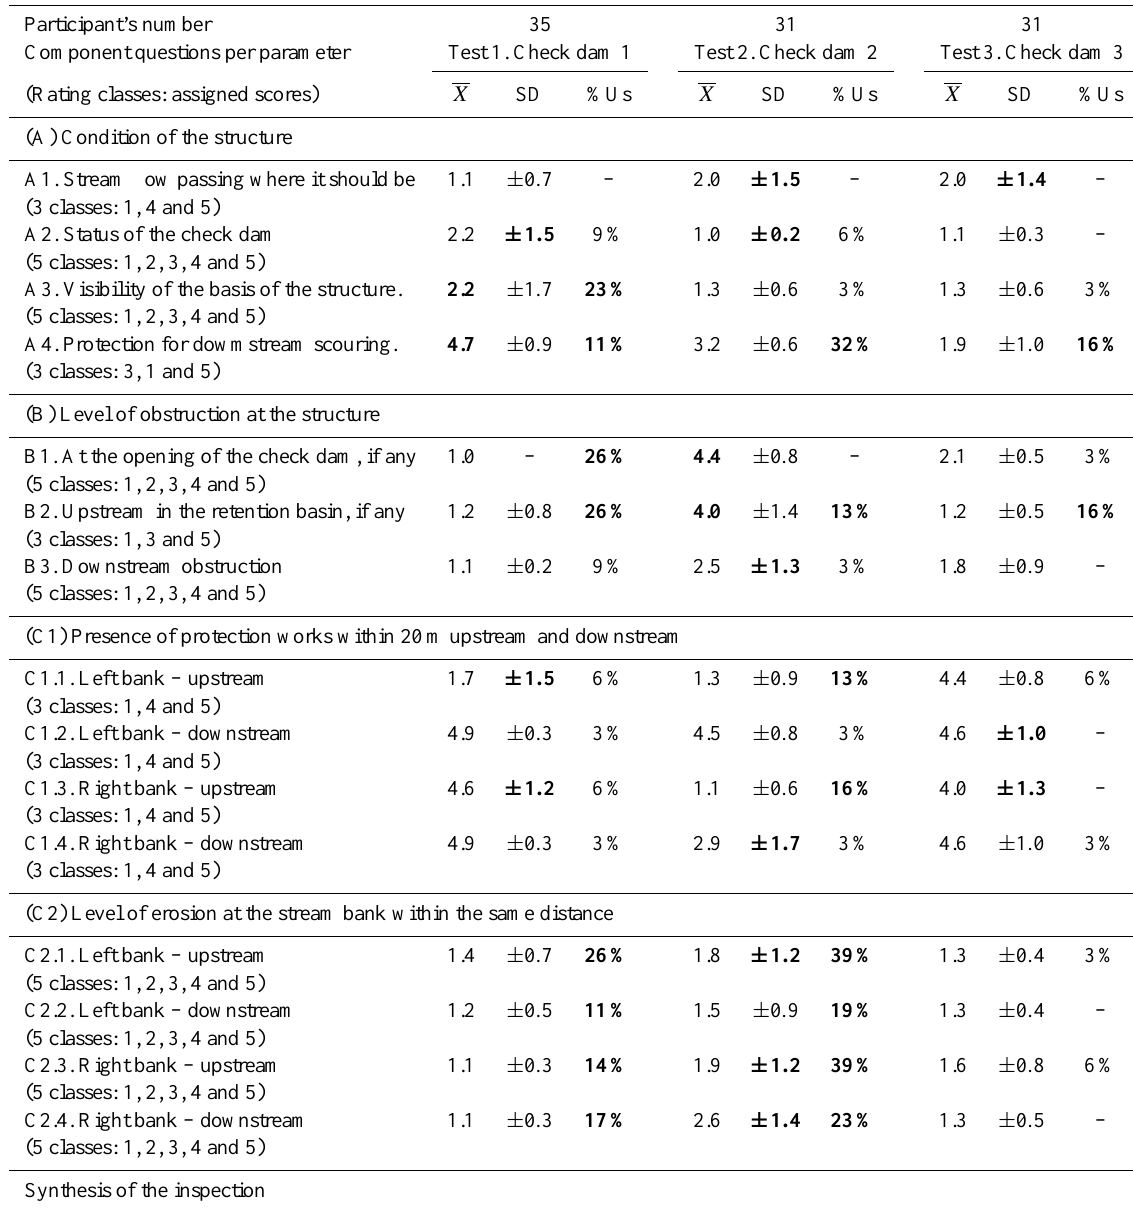
Table 6. Evaluation of scores for the data collected in the inspection tests for check dams. The values in bold distinguish the lowest perfor-